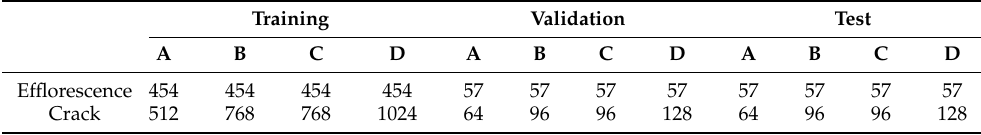
Table 2. The number of records in the dataset.